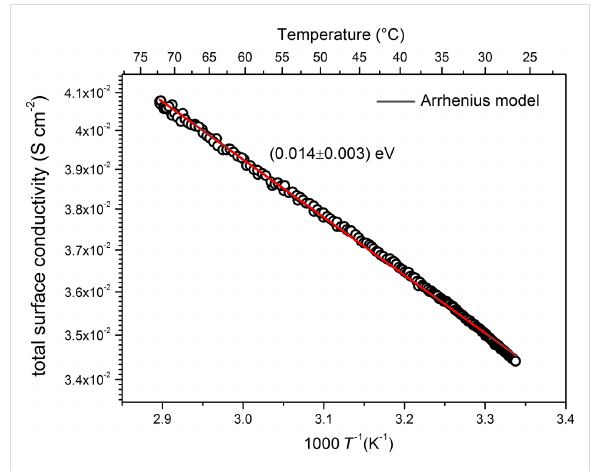
Figure 10: The temperature dependence of the total surface conduc- tivity of the analyzed GO-P